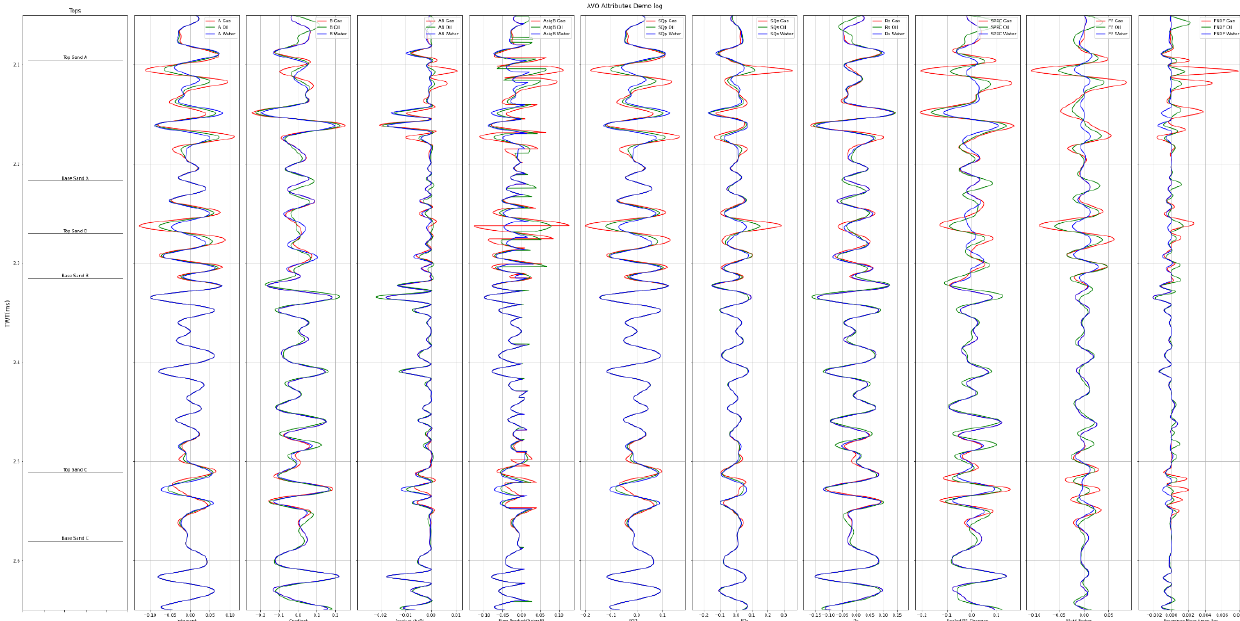
Figure 3. Several AVO attributes extracted from well log data.